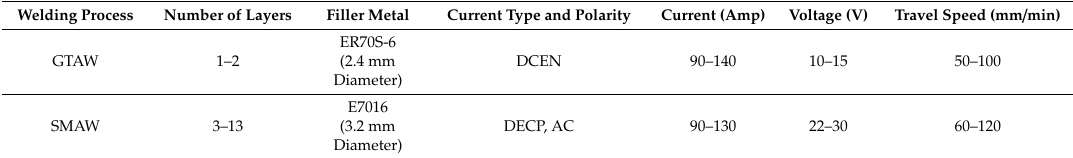
Table 1. Welding process conditions for weld specimens preparation.